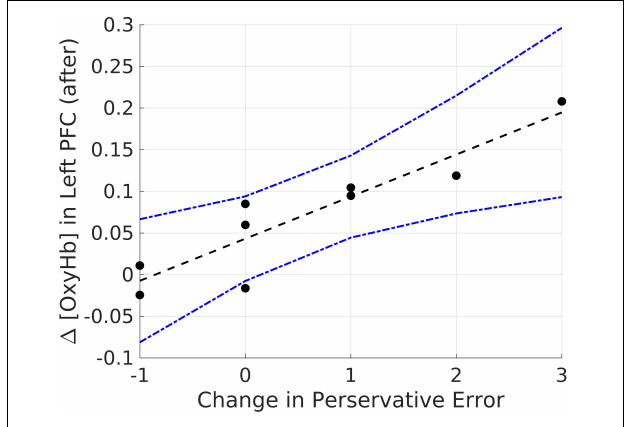
FIGURE 6 | Bivariate correlations between oxyHB and change in perseverative errors for males in the Stress